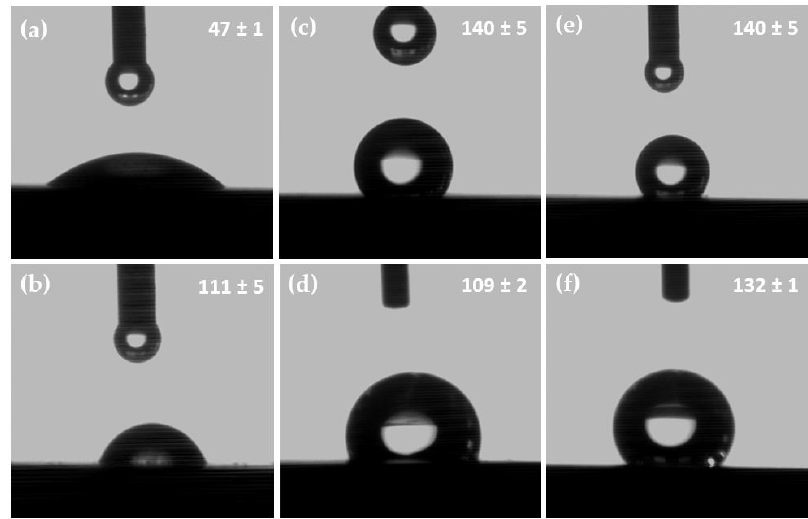
Figure 3. Water contact angles for the different titanium surface treatments. ( a ) Polished Ti6Al4V; ( b ) Acid etched Ti6Al4V; ( c ) Nanotubes in Ti35Nb10Ta obtained at 15 V 45 min; ( d ) Nanotubes in Ti35Nb10Ta obtained at 15 V 45 min with heat treatment; ( e ) Nanotubes in Ti35Nb10Ta obtained at